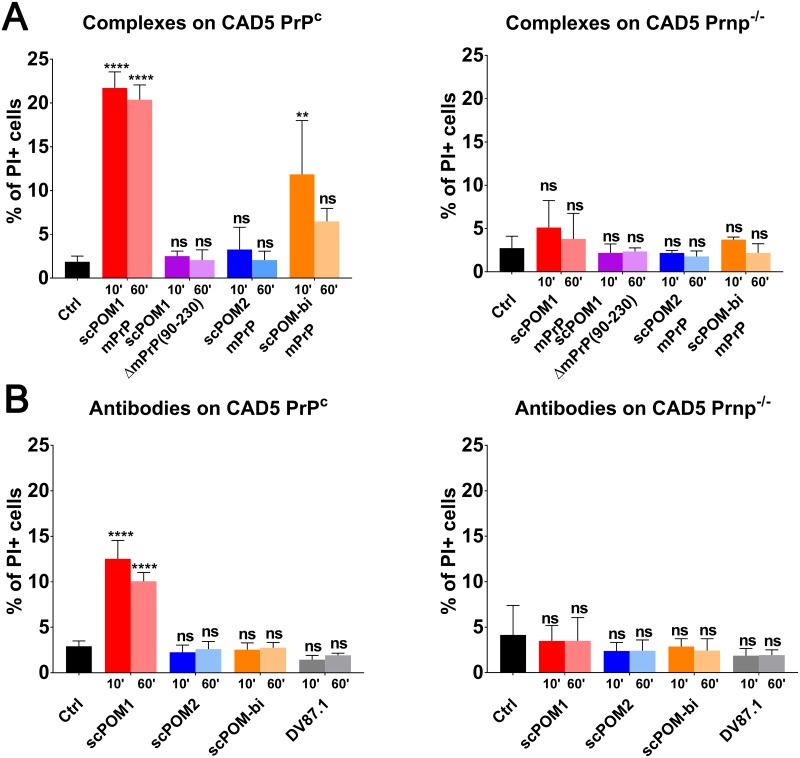
scPOM-bi does not induce toxicity on CAD5 expressing PrPC in comparison to scPOM1.The percentage of PI positive cells for different mPrP:antibodies complexes (A) or antibodies alone (B) on CAD5 PrPC (left) and on CAD5 Prnp-/- (right) are shown; each sample was added to cells after 10’ or 60’ of incubation at RT. The scPOM1:mPrP soluble oligomers caused toxicity in PrPC-expressing CAD5 cells but not in PrPC knock-out (PrP-/-) CAD5. No toxicity was detected when scPOM1 was in complex with the truncated ΔmPrP90-230 lacking the FT. Addition of the scPOM2:mPrP complex resulted in no toxicity, as well. Addition of the scPOM-bi:mPrP material to cells 10 minutes after complex formation resulted in toxicity, albeit lower than with scPOM1. However, toxicity was not significant if the material was added 60 minutes after complex formation. (n = 4 for all samples tested).